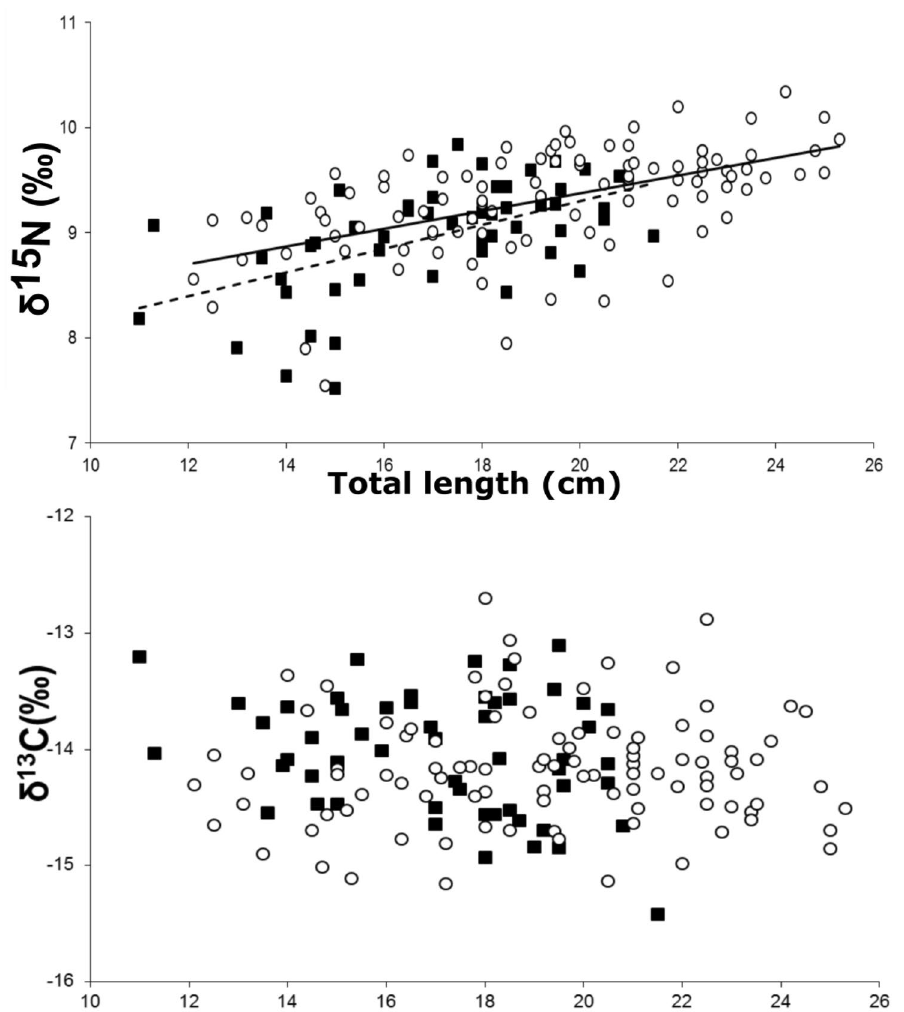
Figure 5. Relationship between fish total length (cm) and δ 15 N (‰) and δ 13 C (‰). Pearson correlations indicated significant increase in δ 15 N values for both L. genivittatus (solid squares, dashed line, R 2 = 0.30, p < 0.001 ) and N. furcosus (open circles, solid line, R 2 = 0.31, p < 0.001 ) with no corresponding increase for δ 13 C